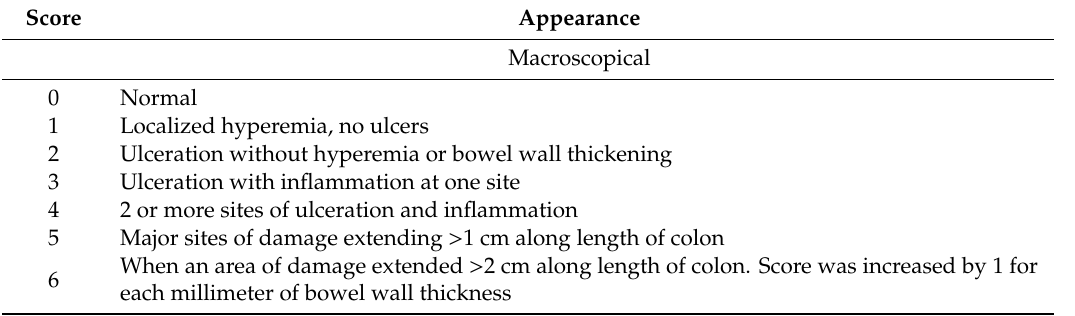
Table 1. Criteria for scoring macroscopic colonic ulceration and